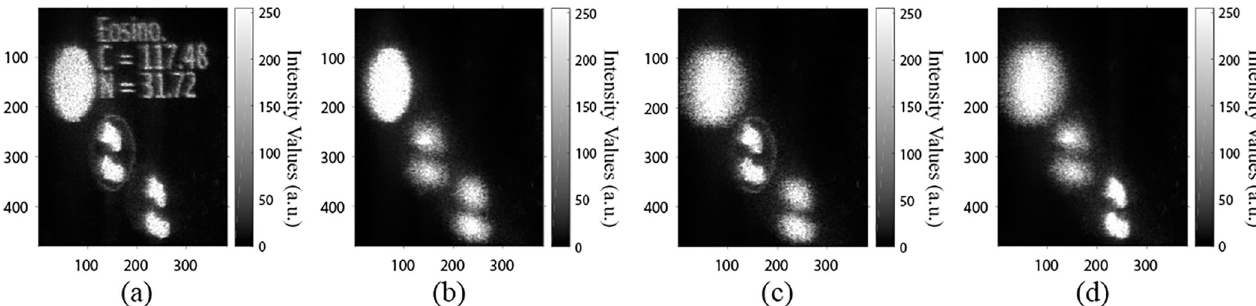
Fig 12. The 3D optical reconstruction of the Eosinophil cell from a single 2D hologram: (a) all structures are focused, (b) the cell is focused, (c) the edges of the cell and its nucleus are focused, and (d) the nucleus only is focused.